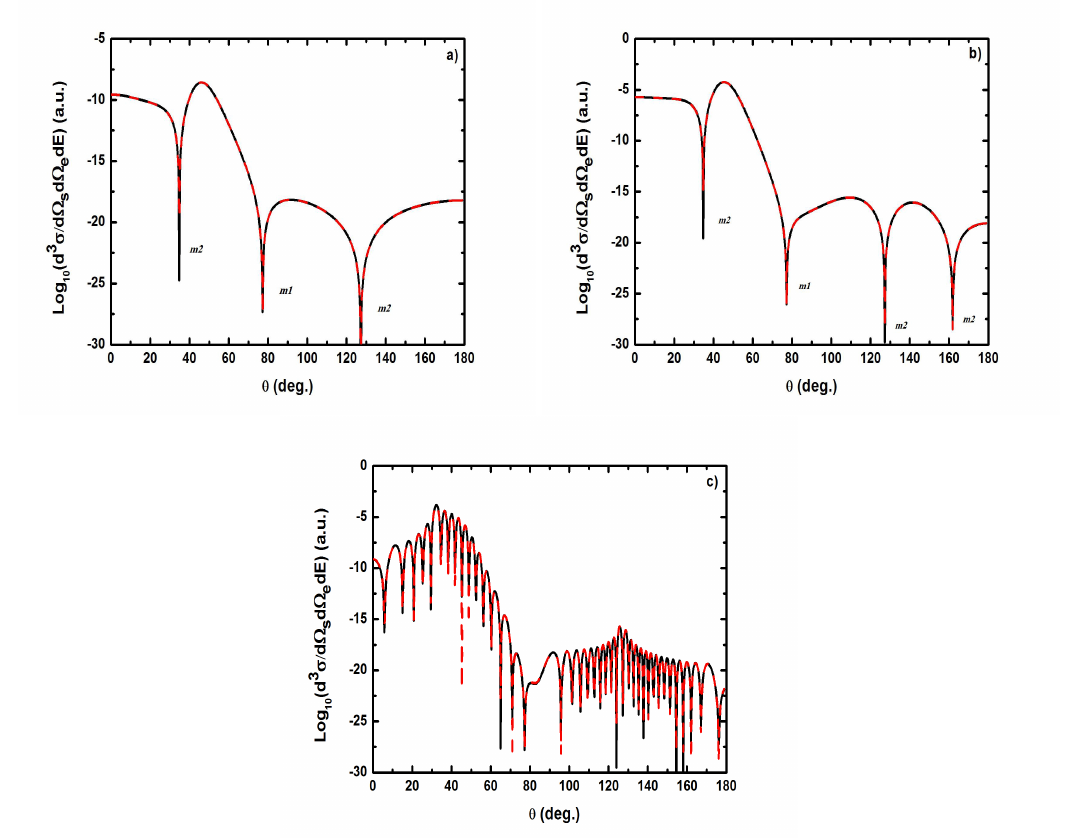
Figure 25. All the parameters are the same as Figure 24, but with the absorption of one photon ( (cid:96) = 1 )